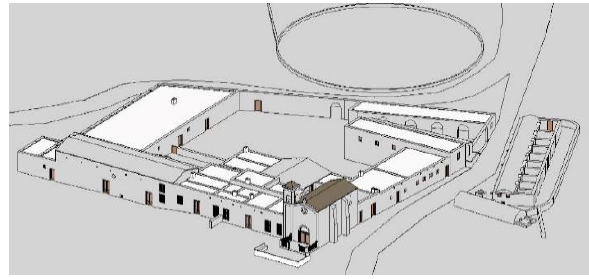
Fig.10. HBIM model of the building made in Revit